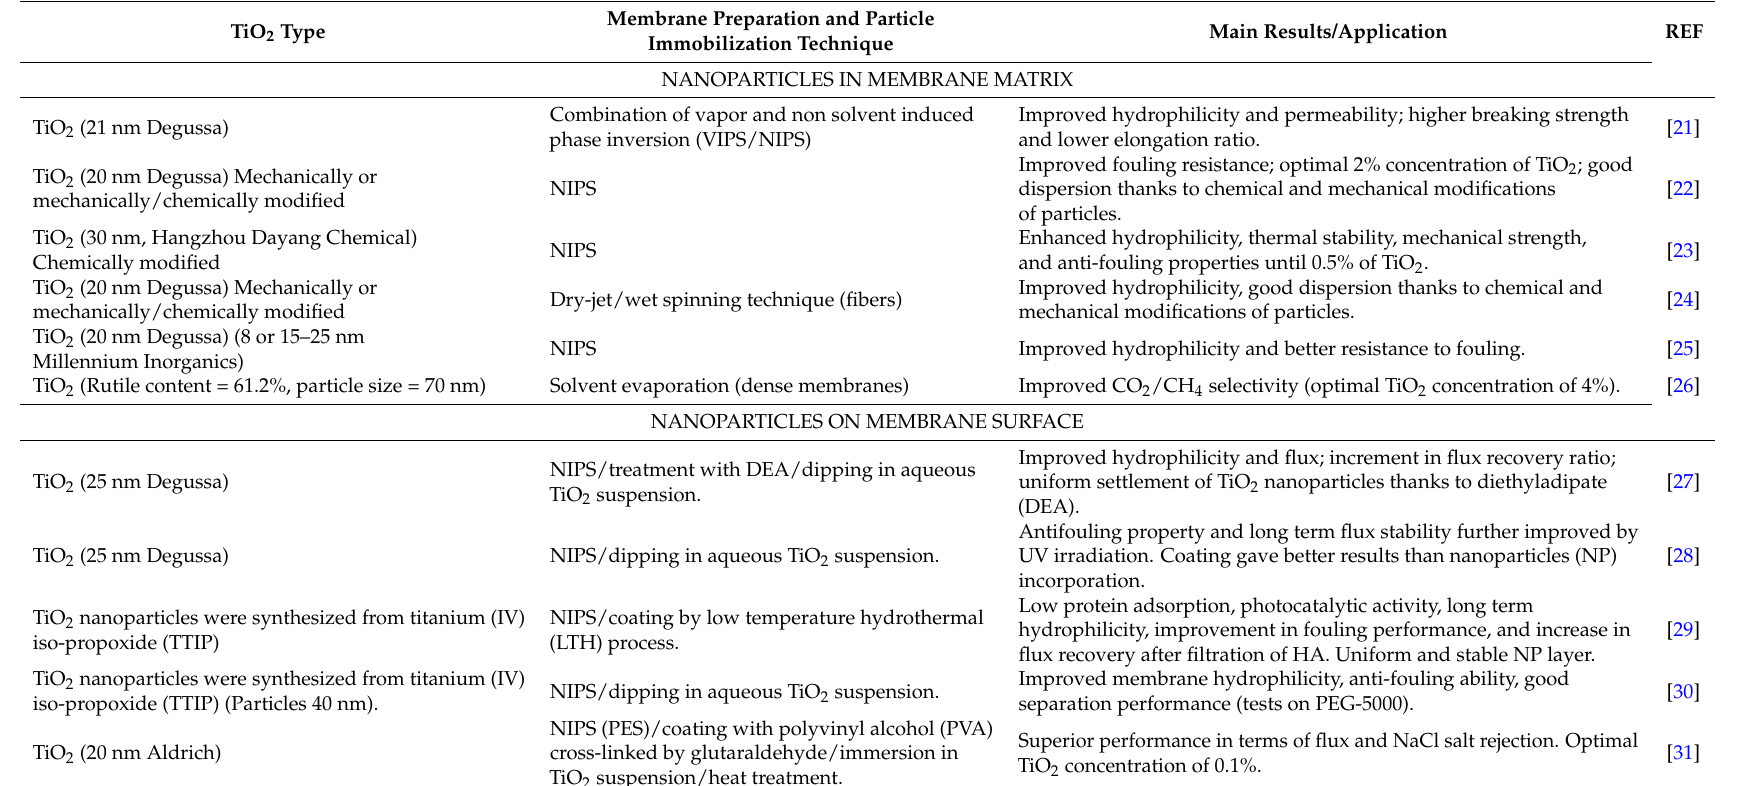
Table 1. Recent publications on PES-TiO 2 membrane